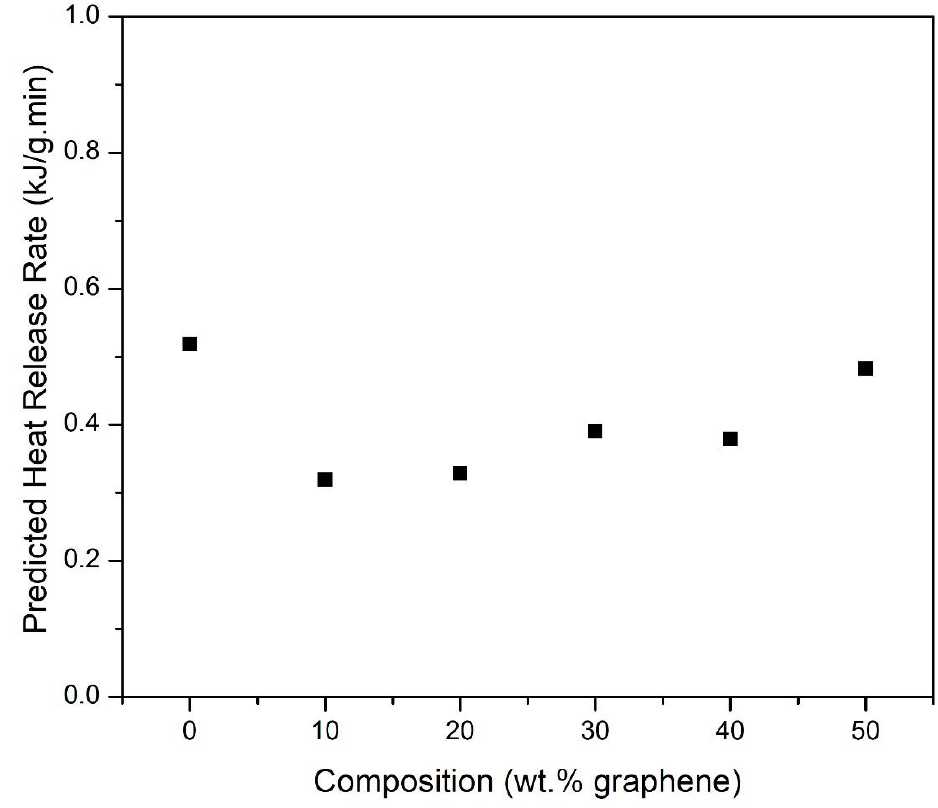
From Equation (3), the theoretical heat release rates of neat polyimide, grapheme, Figure 9. Enthalpy changes of neat PI and PI-NGS composites due to the degradation of the imide Figure 9. Enthalpy changes of neat PI and PI-NGS composites due to the degradation of the imide and polyimide-graphene composites were obtained and graphed in Figure 10. The trend bond as measured by DSC in nitrogen and air at a heating rate of 10 °C/min . bond as measured by DSC in nitrogen and air at a heating rate of 10 ◦ C/min. shows that the heat release rate decreases by 62% at 10 wt.% graphene.